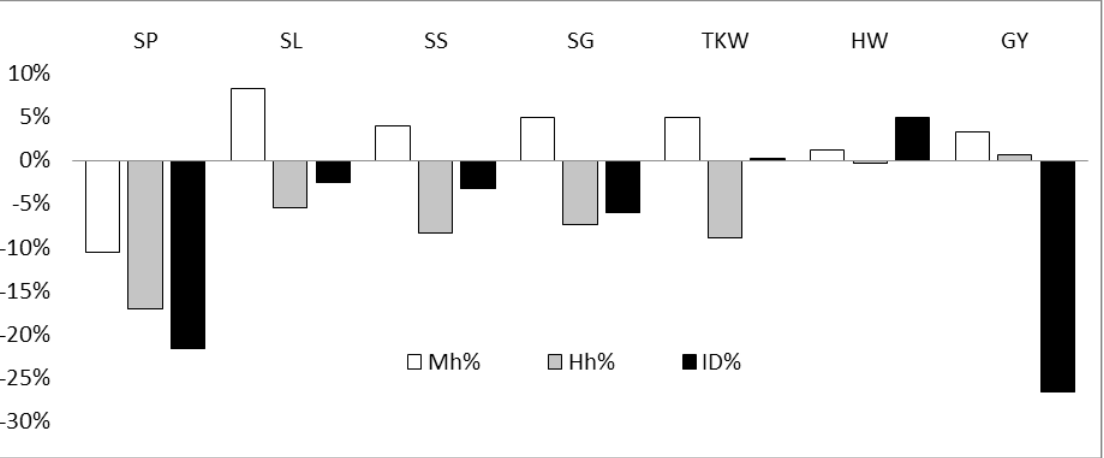
1 Quantitative traits. SP: spikes per plant, SL: spike length, SS = spikelets per spike, SG = number of grain per spike, TKW= thousand kernel weight, HW= hectoliter weight, GY= grain yield